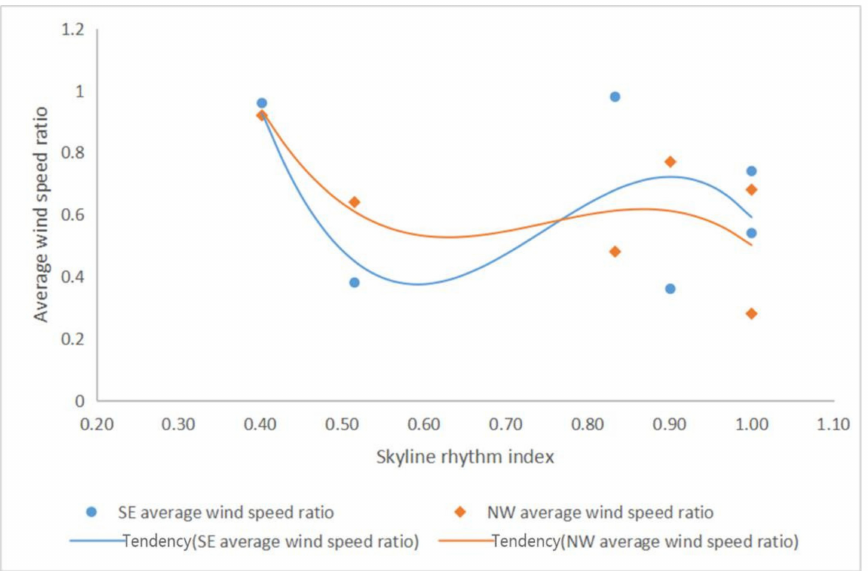
Figure 23. The relationship between the average wind speed ratio and skyline rhythm